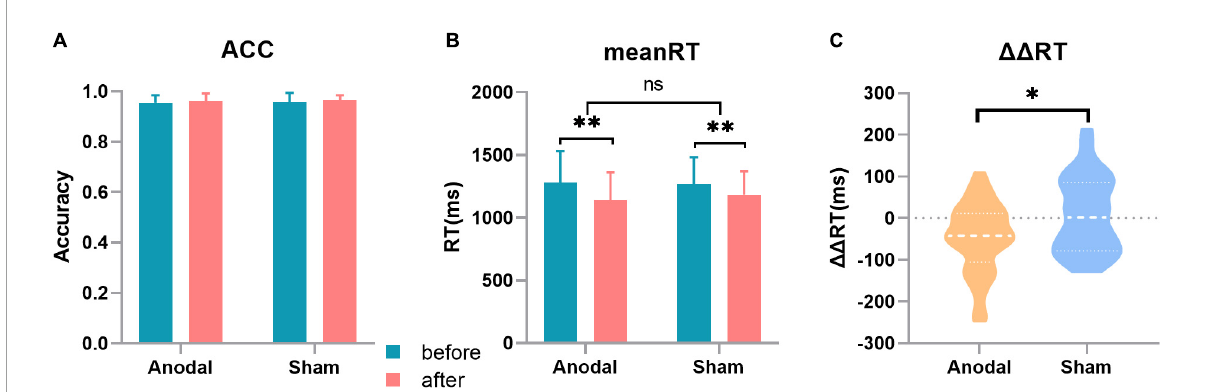
FIGURE2 Behavior results. (A) Accuracy (ACC) in the two stages, with no significant changes in the different sessions or stages. (B) Mean response time (RT) in the two stages. (C) Change in the distractor effect in the two stages [distractor effect ( (cid:49) RT) = RT with distraction -RT without distraction ]. Error bar: The standard deviation estimation of the sample. ∗ p < 0.05; ∗∗ p <